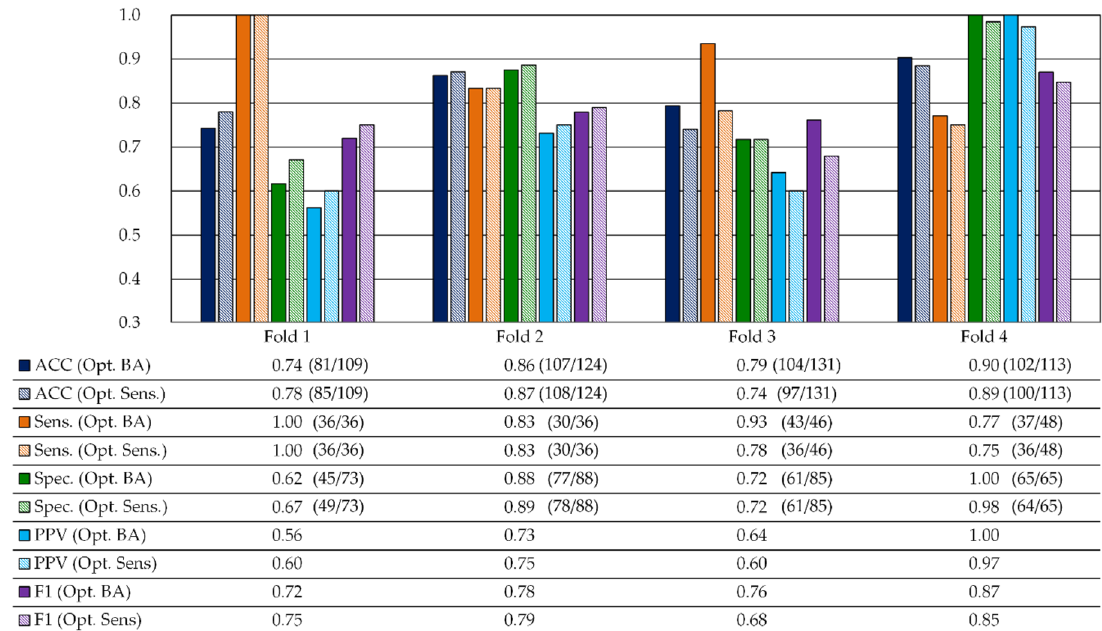
Figure 12. Average image classification results of each fold in the test set using both metrics (BA and Sensitivity) for the hyperparameter optimization of the SVM Linear kernel.